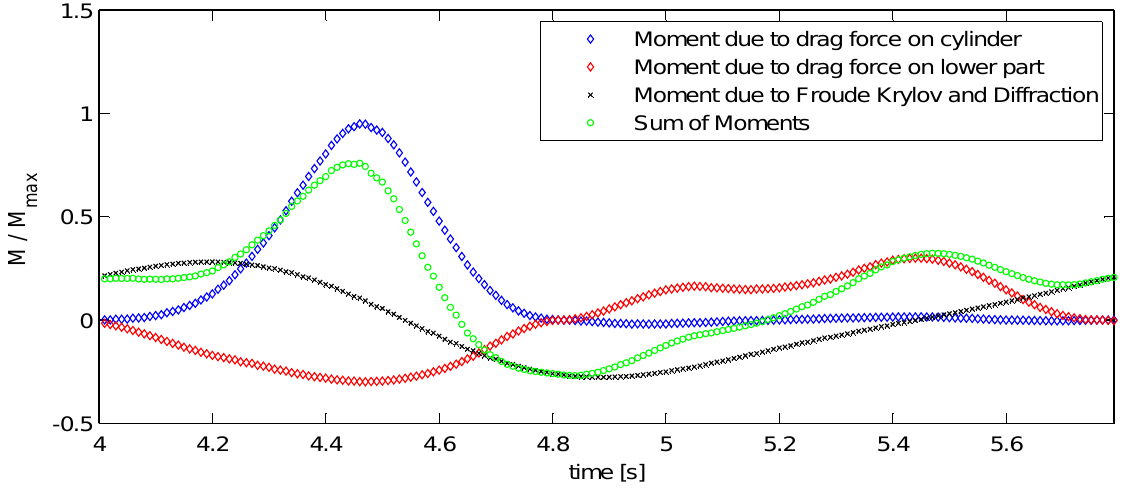
Figure 12. Illustration of the different wave load component contributions on pitch